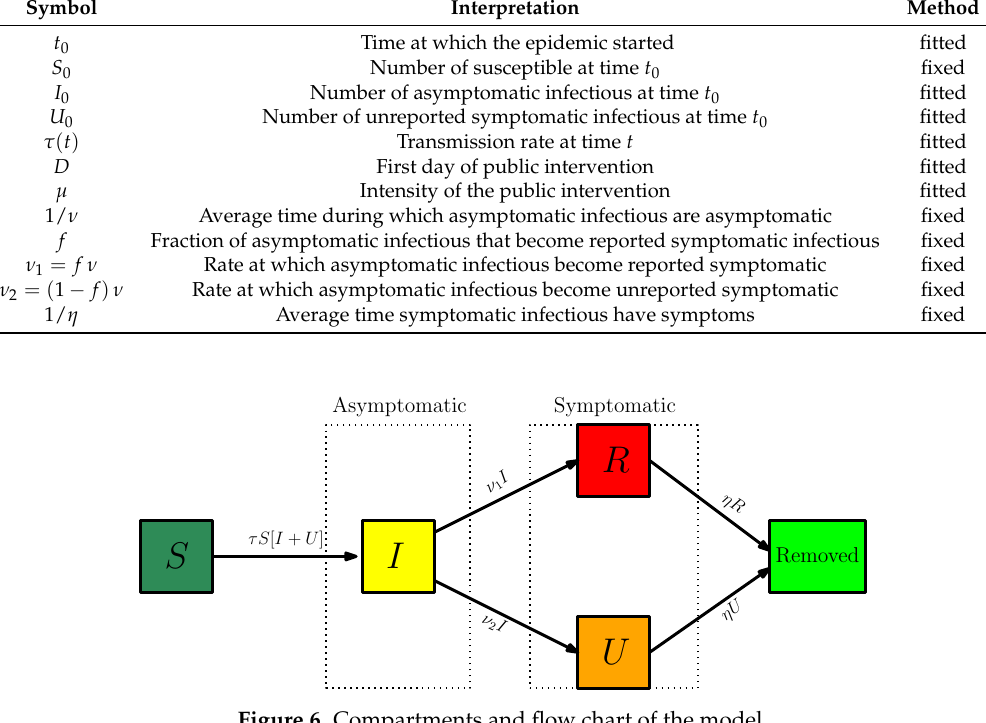
Figure 6. Compartments and flow chart of the